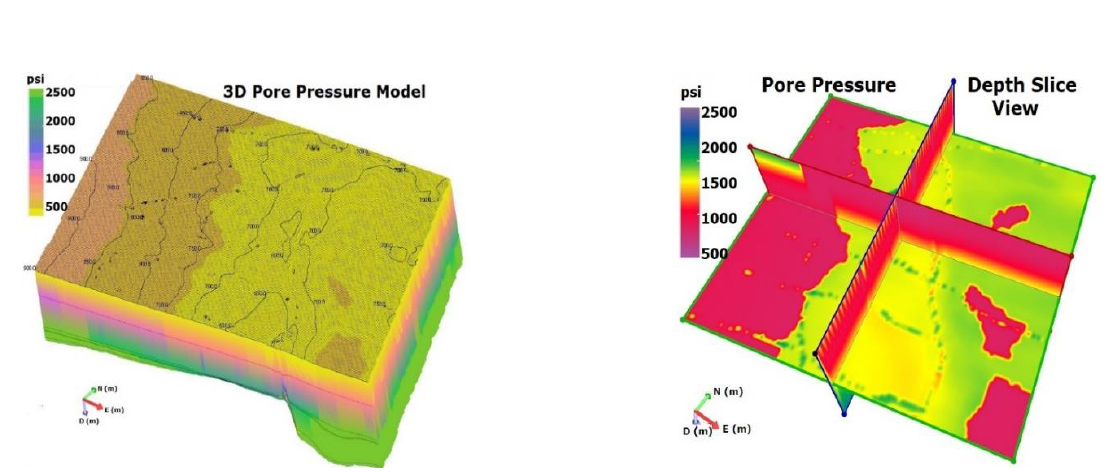
Figure 14. 3D distribution of interpreted pore pressure with contours on the surface layer, the right side is depth slice of pore pressure at